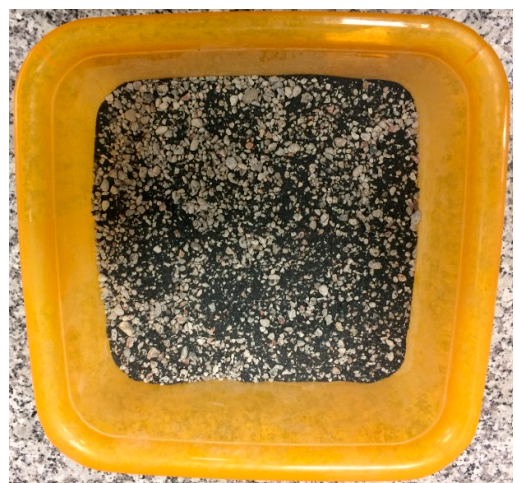
Figure 4. Prepared composition of RCA with rubber chips.